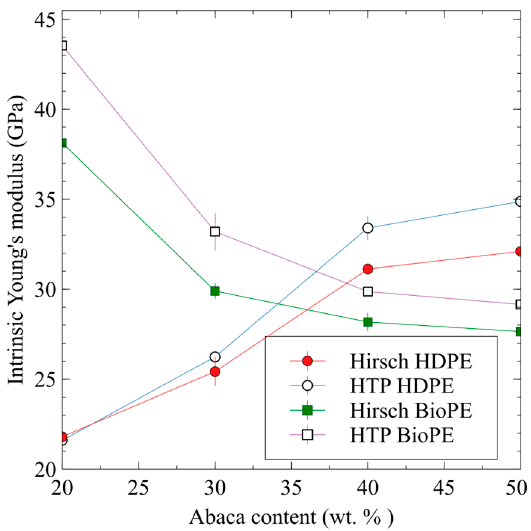
Figure 3. Abaca fiber’s intrinsic tensile Young’s modulus obtained from micromechanical models against fiber contents.